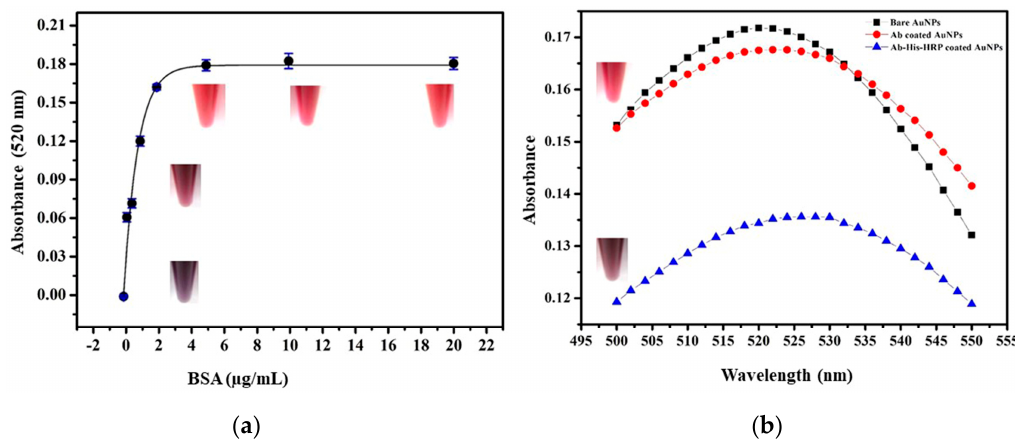
Figure 1. Plot depicting ( a ) the titration of gold nanoparticle with BSA for the binding saturation study, each data point (black dots) represent the error bar, obtained from three sets of experiments. ( b ) UV-Visible characterization of a developed peptide nanoprobe.